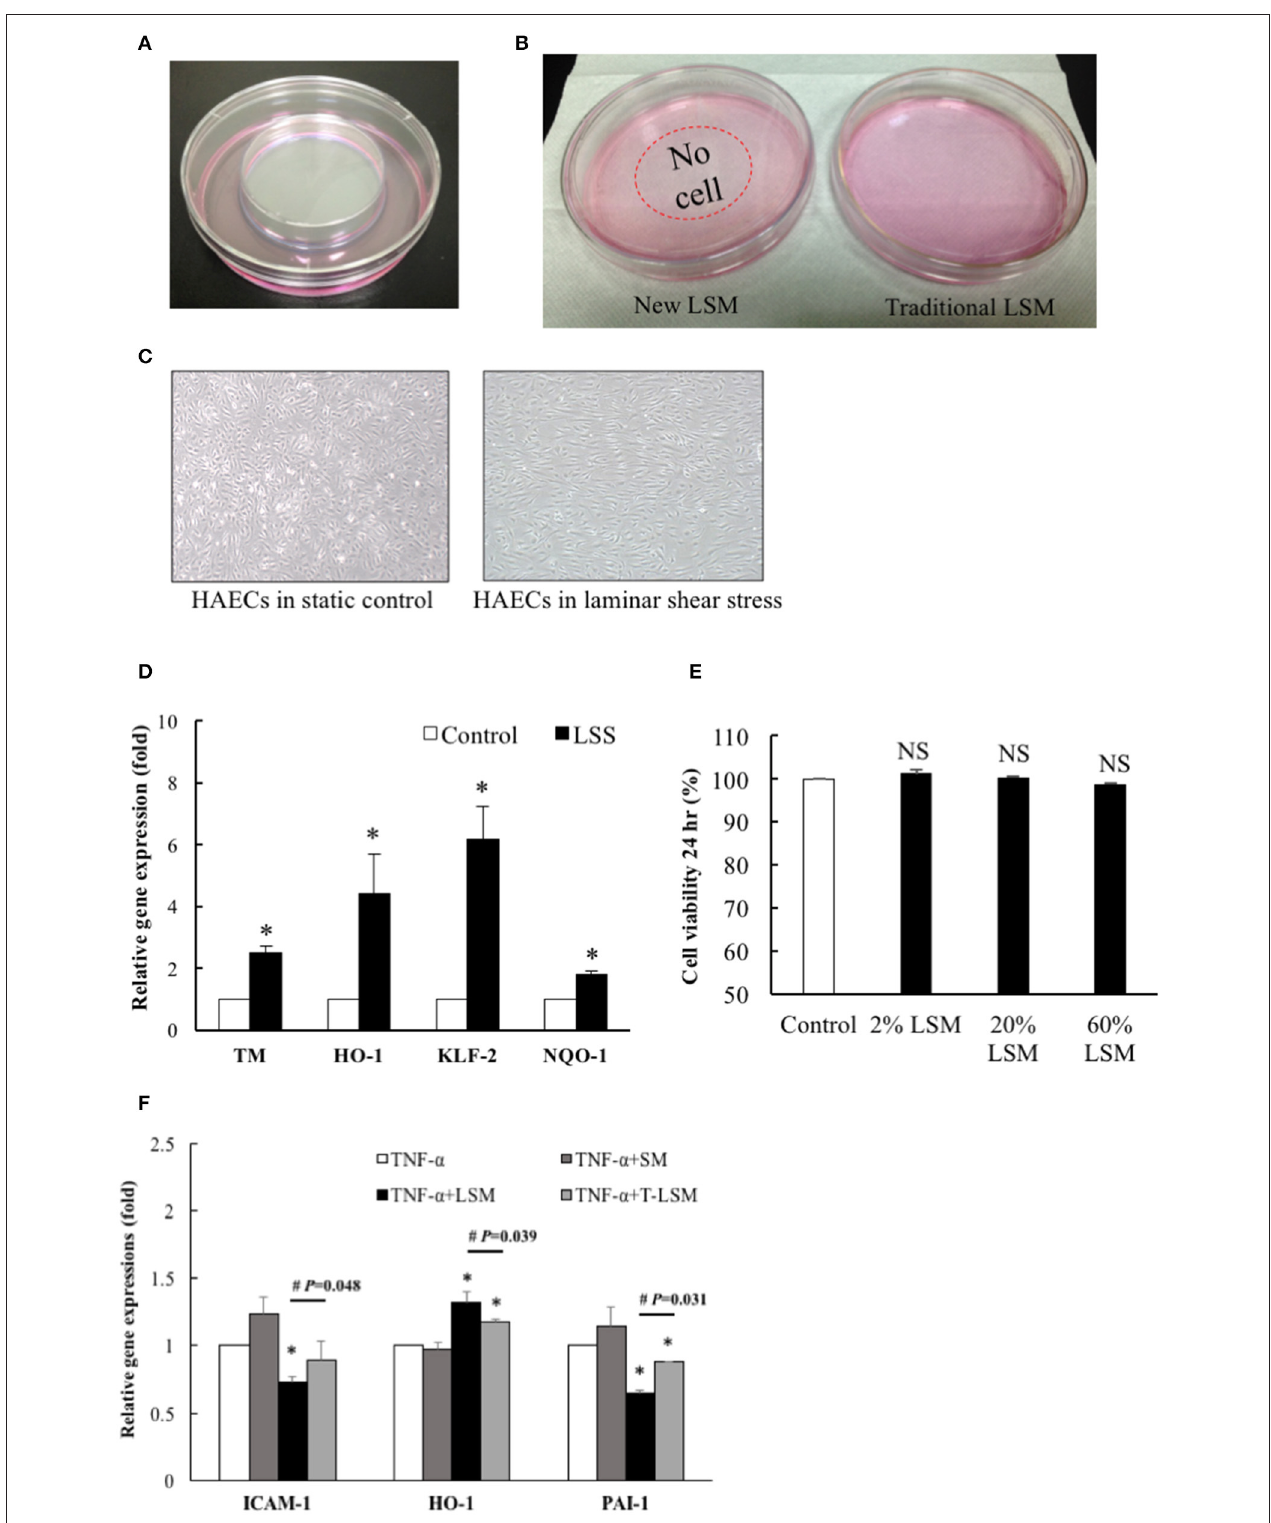
FIGURE 1 | HAECs exposed to LSS from a modified cone-and-plate shear. (A) The new LSS system was designed with a central empty circle (diameter is 5.14cm) in a 10-cm dish, surrounded by cultured HAECs. (B) After exposure to shear stress (15 dynes/cm 2 ) from the modified cone-and-plate shear device for 24h, the new LSM showed different phenotypes: medium of the traditional LSS was less clear (right), while the medium of the new LSS system was clearer (left). (C) Morphology of